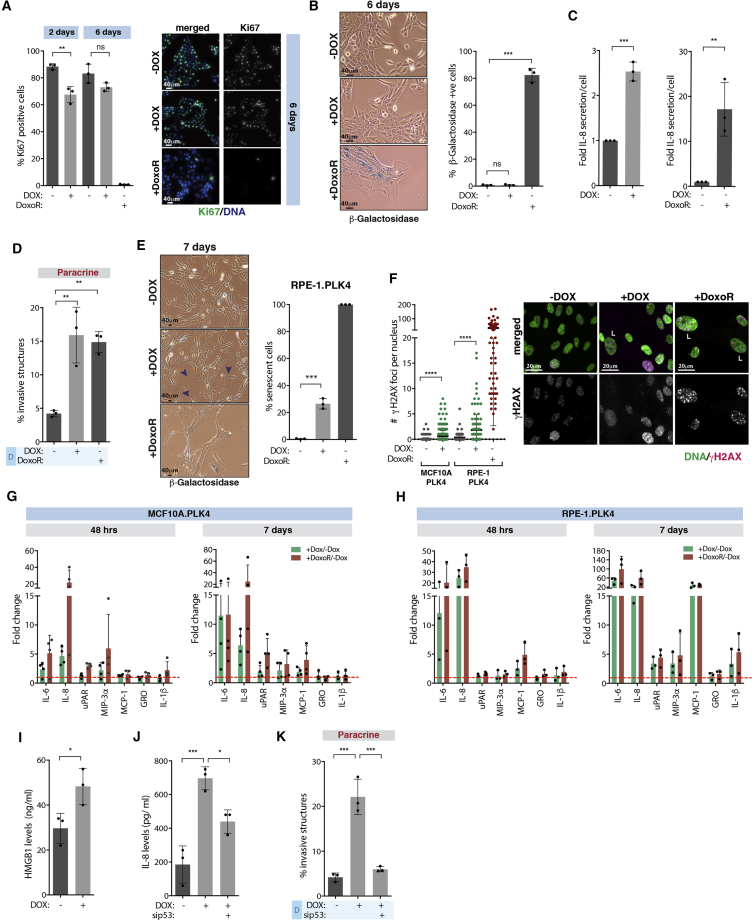
Centrosome Amplification Induces an Early Stress Response that Leads to Altered Secretion(A) Left, quantification of Ki67 positive cells. Right, cells stained for Ki67. Scale bar: 40 μM.(B) Left, cells stained for β-galactosidase (blue). Right, quantification of β-galactosidase positive cells after 6 days. Scale bar: 40 μM.(C) Relative IL-8 secretion (fold, ng/cell) in cells with extra centrosomes (Left) or treated with DoxoR (Right).(D) Quantification of invasive structures.(E) Left, cells stained for β-galactosidase (blue). Right, quantification of senescence in RPE-1.PLK4 cells. Note that senescence was assessed by enlarged morphology (purple arrowheads). Scale bar: 40 μM.(F) Left, quantification of γH2AX foci. Right, cells were stained for γH2AX. L, large nuclei. Number of cells MCF10A.PLK4 −DOX = 469; +DOX = 466; and RPE-1.PLK4 −DOX = 155; +DOX = 115; +DoxoR = 84. Scale bar: 20 μM.(G and H) (G) Fold change of secreted SASP components in MCF10A and (H) RPE-1 cells.(I) HMGB1 secretion after 48 hr.(J) IL-8 secretion after p53 depletion (48 hr).(K) Quantification of invasive structures.Graphic in (G) represents 4 independent experiments; for all other graphics, error bars represent mean ± SD from three independent experiments. ∗p < 0.05, ∗∗p < 0.01, ∗∗∗p < 0.001, ∗∗∗∗p < 0.0001; ns, not significant.See also Figure S5 and Table S1.